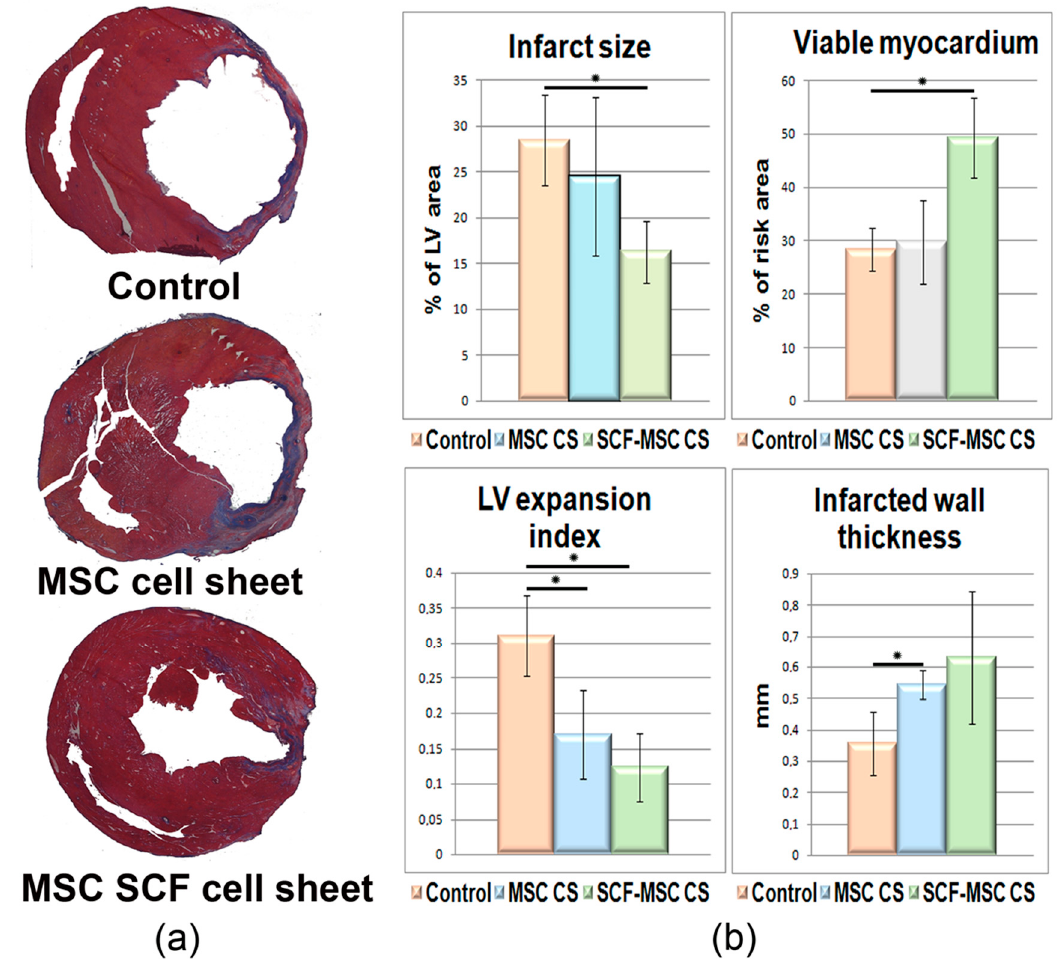
Figure 7. Morphometric analysis of LV remodeling at day 14 after CS transplantation. ( a ) Representative images of Mallory trichrome-stained myocardial sections from the sham-operated (control, n = 4), MSC CS ( n = 5) and SCF-MSC ( n = 6) groups: scar tissue and viable myocardium are in blue and red, respectively. ( b ) Quantitative analysis of LV morphometric parameters: infarct size, viable myocardium, infarcted wall thickness, LV expansion index. Data are presented as mean ± SD (Mann–Whitney U-test). The black asterisk ( ⁕ ) indicates statistical significance; infarct size: MSC SCF CS vs. control group, p = 0.02; viable myocardium: MSC SCF CS vs. control group, p = 0.02; LV expansion: MSC SCF CS vs. control group, p = 0.04; infarcted wall thickness: MSC vs. control group, p = 0.025, MSC SCF vs. control group—not statistically significant.